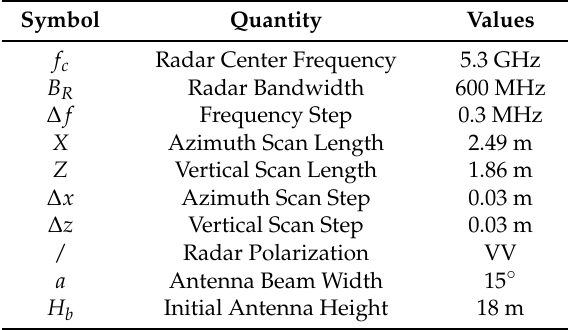
Table 1. System parameters for the GB-TomoSAR simulation and outdoor experiment.